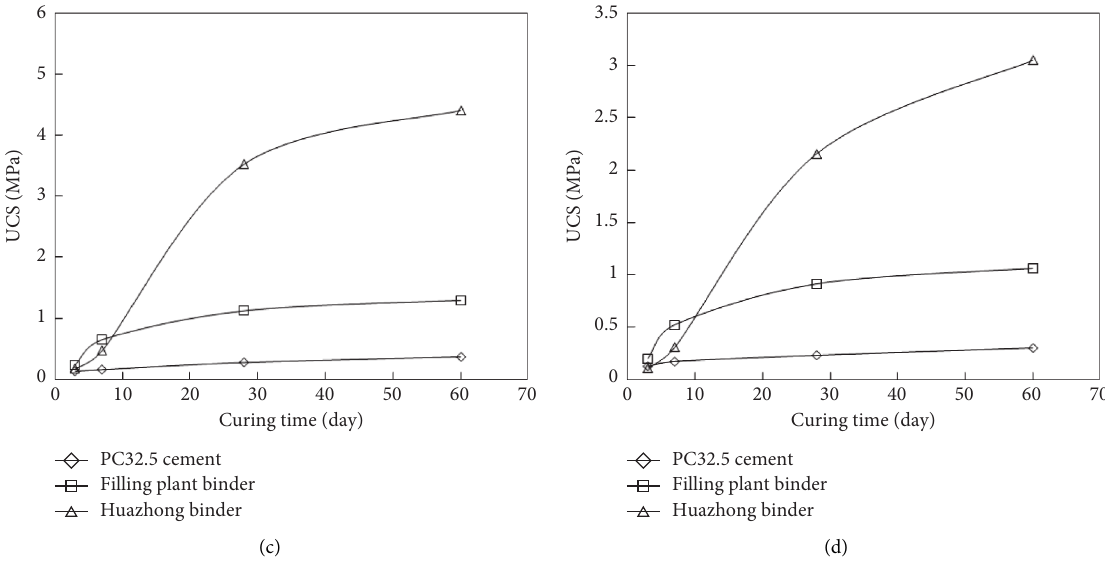
Figure 5: Variation of UCS with curing time at different b/t . (a) b/t is 1:4. (b) b/t is 1:6. (c) b/t is 1 :8. (d) b/t is